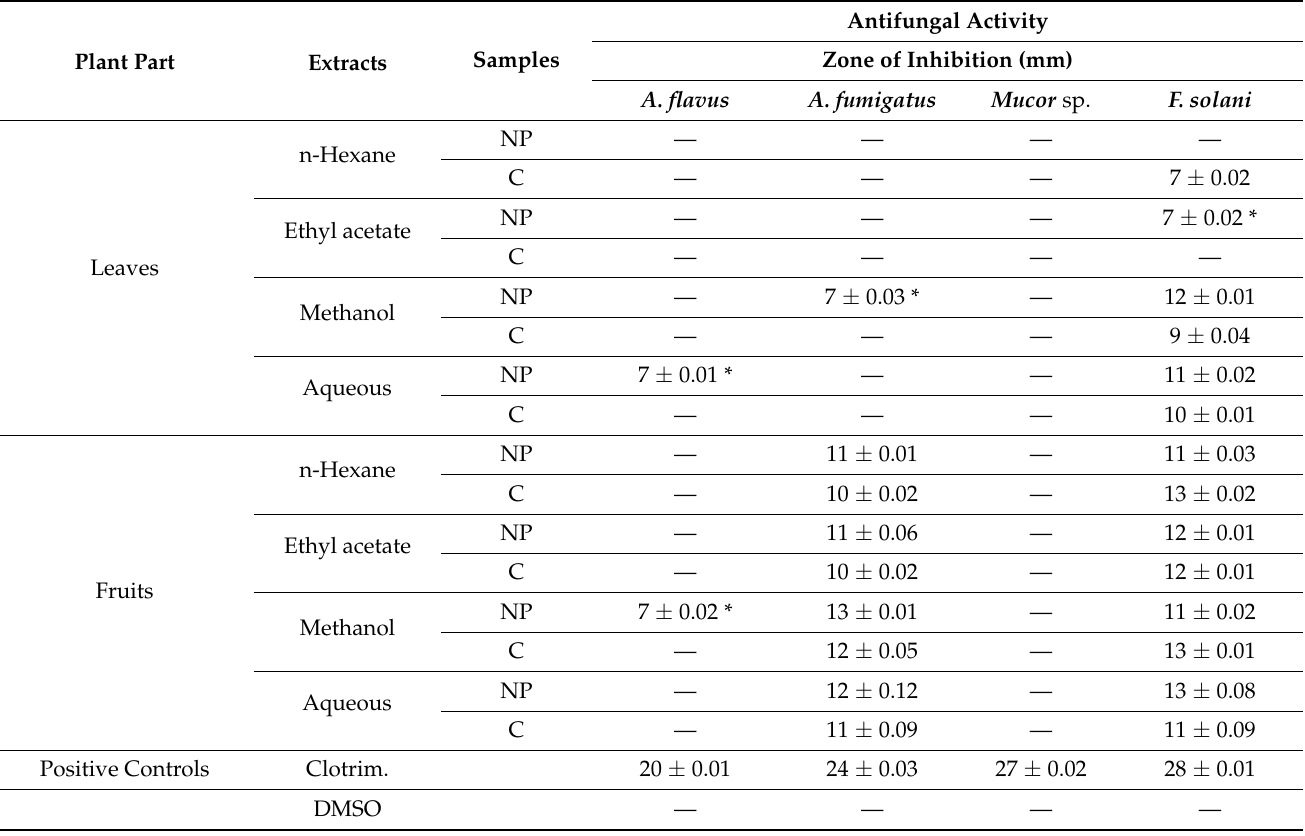
Table 3. Antifungal activity of crude extracts and nanoparticles of leaves and fruits of C. colocynthis .